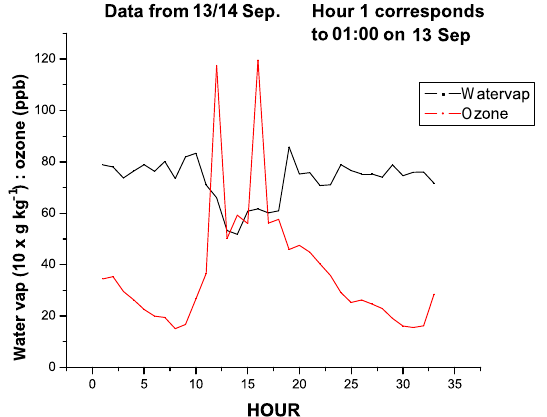
Figure 12. The ozone concentration and absolute humidity for a 35h sampling period on 13 and 14 September that included two ozone spikes and only sampled ambient TOM.